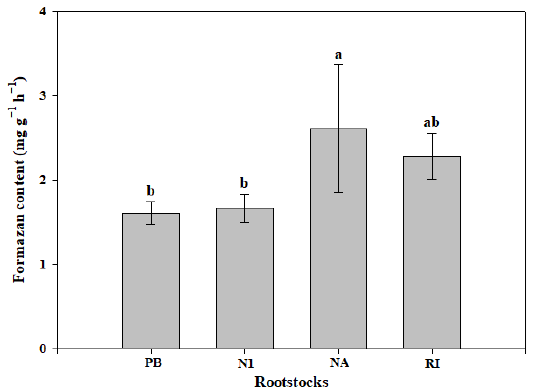
Figure 3. Root activity of one scion and three rootstocks by cutting: PB: scion of Rosa hybrida cv. Pink Beauty; N1: rootstock of Rosa multiflora cv. Hort No 1; NA: rootstock of Rosa canina cv. Natal brier; RI: rootstock of Rosa indica cv. Major. Vertical bars are standard deviations ( n = 3). Small letters at the data points indicate mean separation between the values by DMRT at p = 0.05.